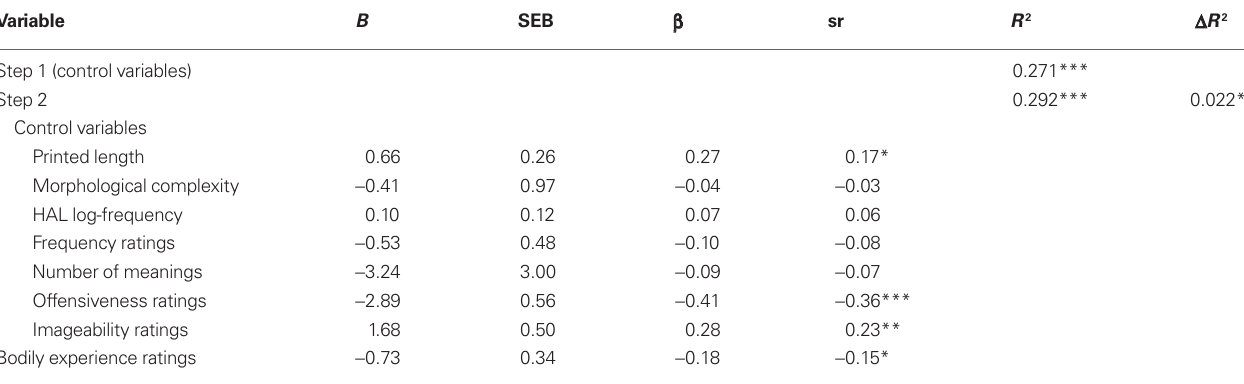
Table 5 | Results of hierarchical multiple regression analysis for insult detection task response error data for Experiment 4.